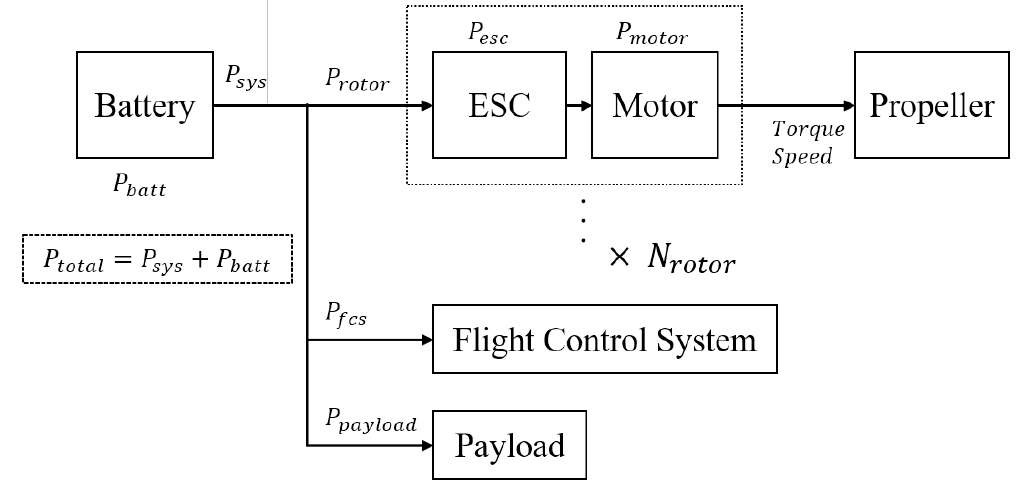
Figure 2. Multicopter UAV system power chain